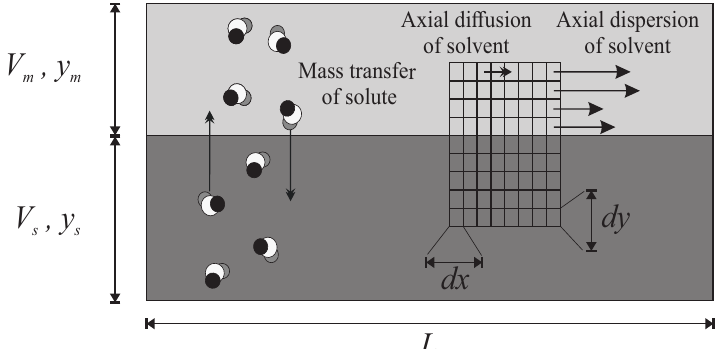
Figure 3. The continuous column model with axial dispersion. A continuous volume of MP (light grey) above a volume of SP (dark grey). Solute molecules diffuse radially in both directions. The move- ment of the mobile solvent is also subjected to an axial dispersion–diffusion phenomenon, around a given average speed. The degrees of freedom of movement can be studied by an infinitesimal fragmentation dx · dy